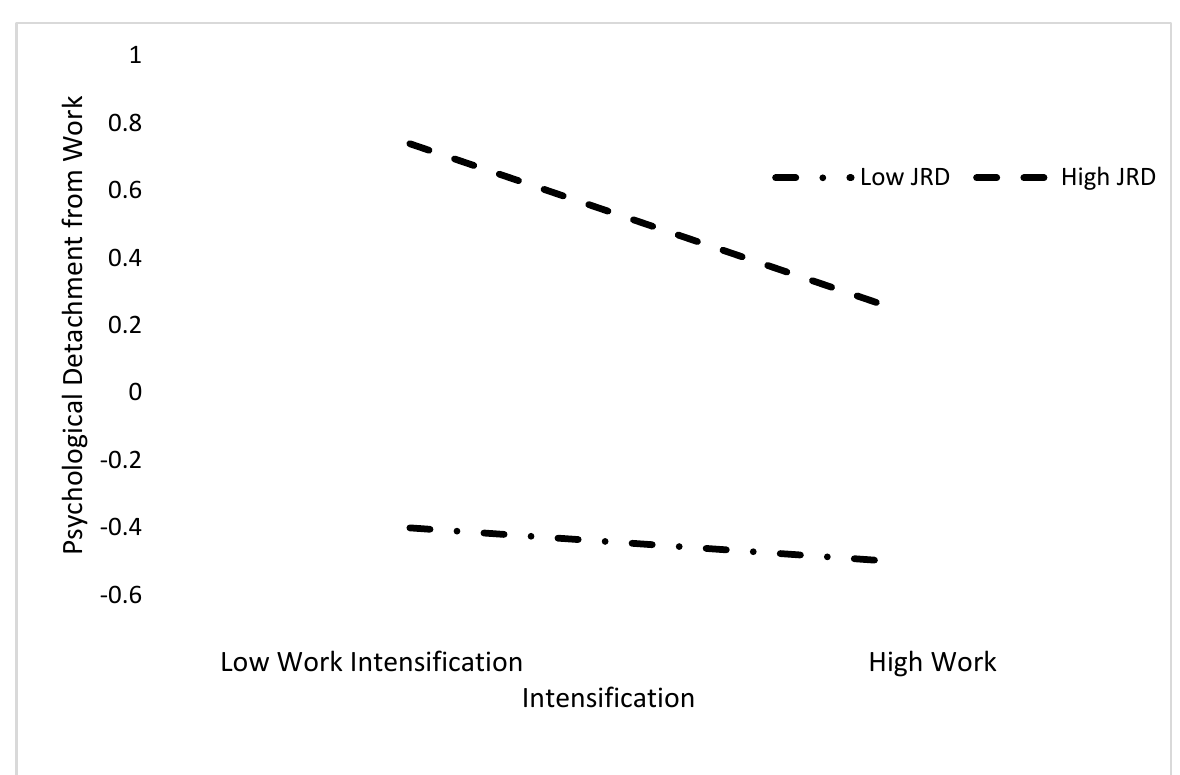
Figure 2. Relationship between work intensification and psychological detachment from work as a function of Job Demands Resources (JD-R) high/low values correspond to 1 SD above/below mean.